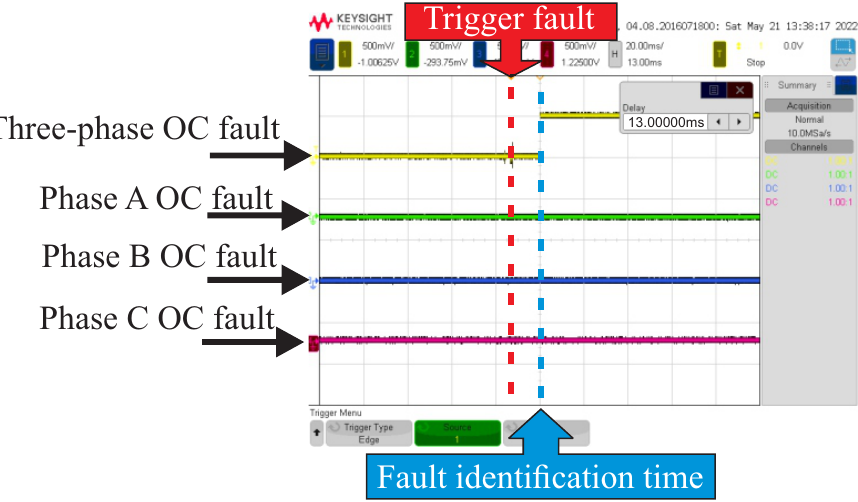
Figure 14. Three-phase open circuit fault identification with 4 × 4 SOM: detection time 13 ms.